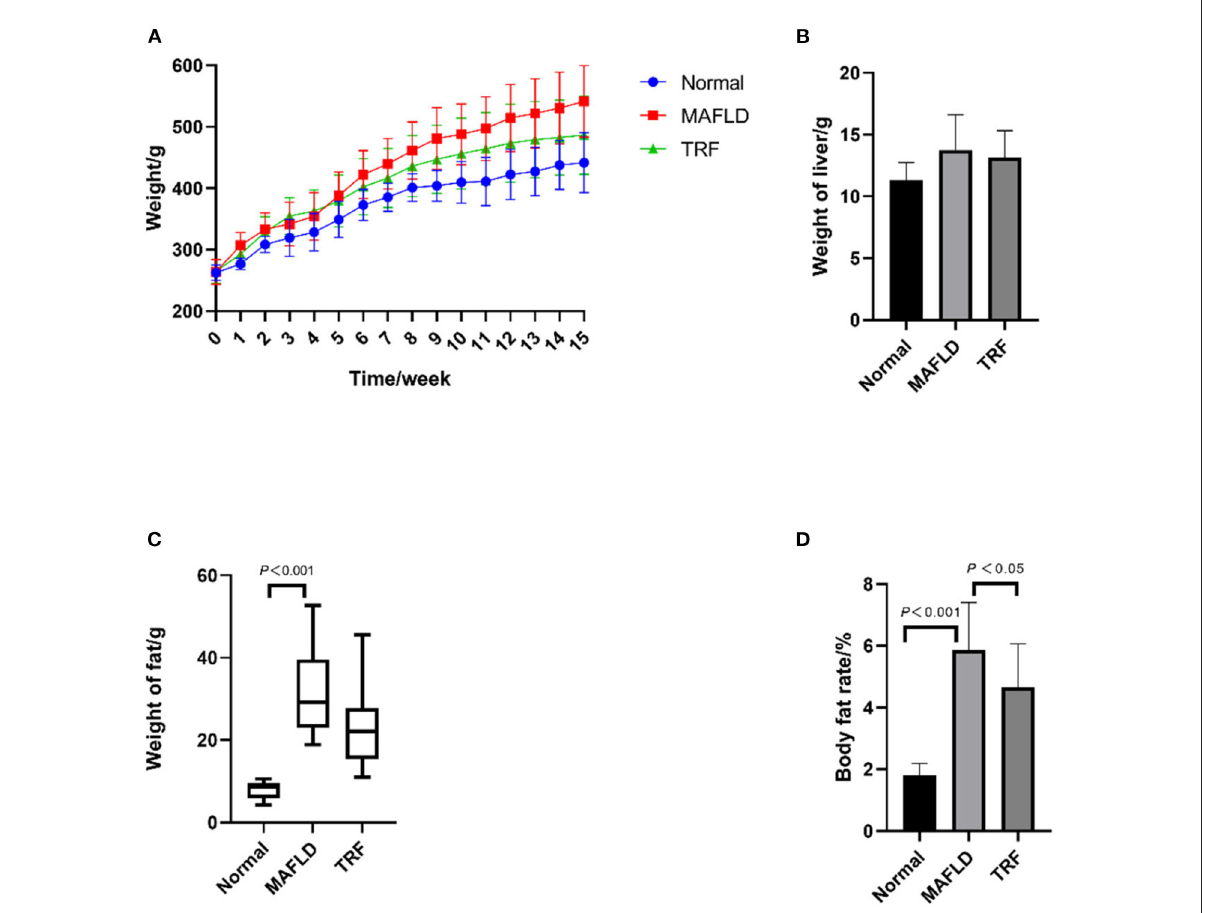
FIGURE1 Physical characteristics. (A) Body weight from 1 to 15 weeks (g); (B) weight of liver (g); (C) weight of perirenal and epididymal fat (g); (D) body fat rate (%). The data are presented as means ± SD or percentile. Normal, rat fed a normal diet ad libitum ; MAFLD (metabolic associated fatty liver disease), rat fed a high-fat diet ad libitum ; TRF (time-restricted feeding), fed high-fat diet (60 kcal% fat) strictly only between 16:00 and 22:00 every